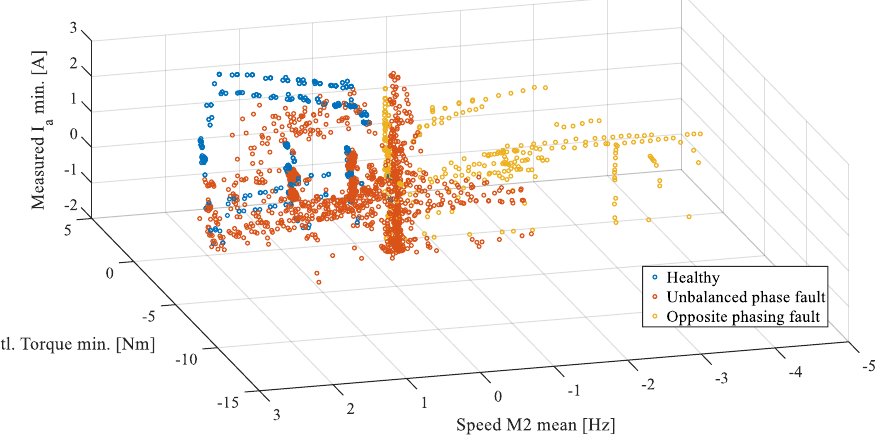
Figure 15. 3D scatterplot after applying raw dataset preprocessing step from the ML workflow.